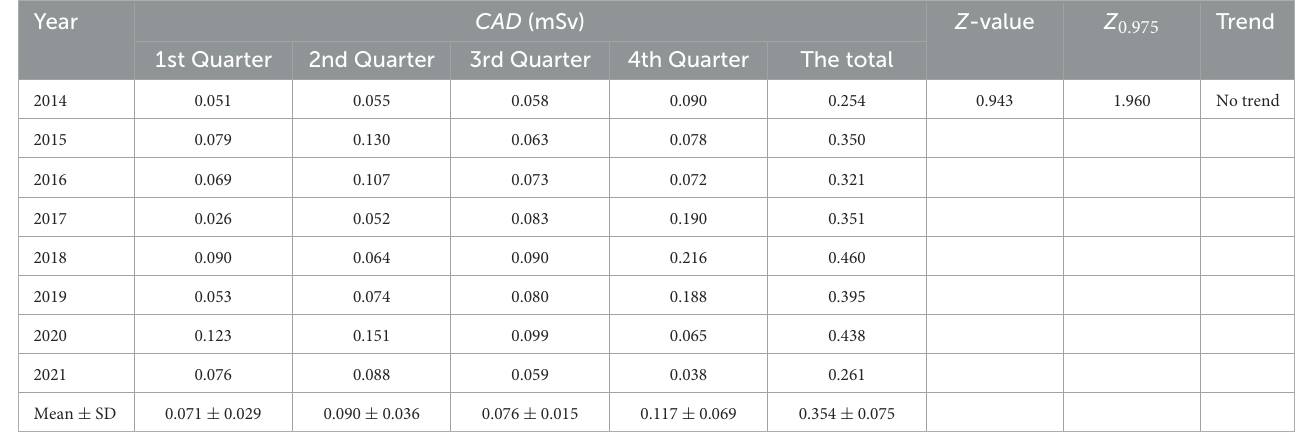
TABLE 6 CAD around SNPP and statistical analysis for the temporal trend from 2014 to 2020.